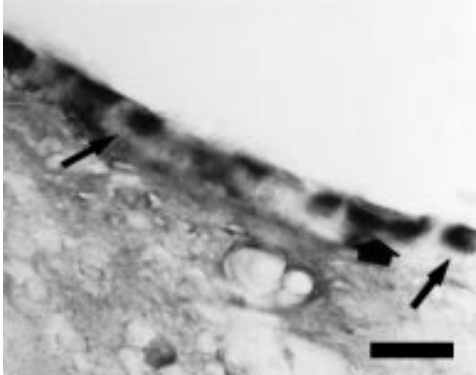
Figure 2 - Expression of a preco- cious oligodendroglial marker (CNPase) in germinative zones of the opossum brain stem. Photomicrograph of a parasagit- tal section passing through the IVv in a P27 animal. Immunore- action with an anti-CNPase poly- clonal antibody using the biotin- avidin-HRP method (Sigma kit). CNPase+ cells at the margins of IVv (thin arrows). Note that the immunoreactive profile pointed at by the thicker arrow seems to be a cell in telophase. Magnification bar = 25 µm.